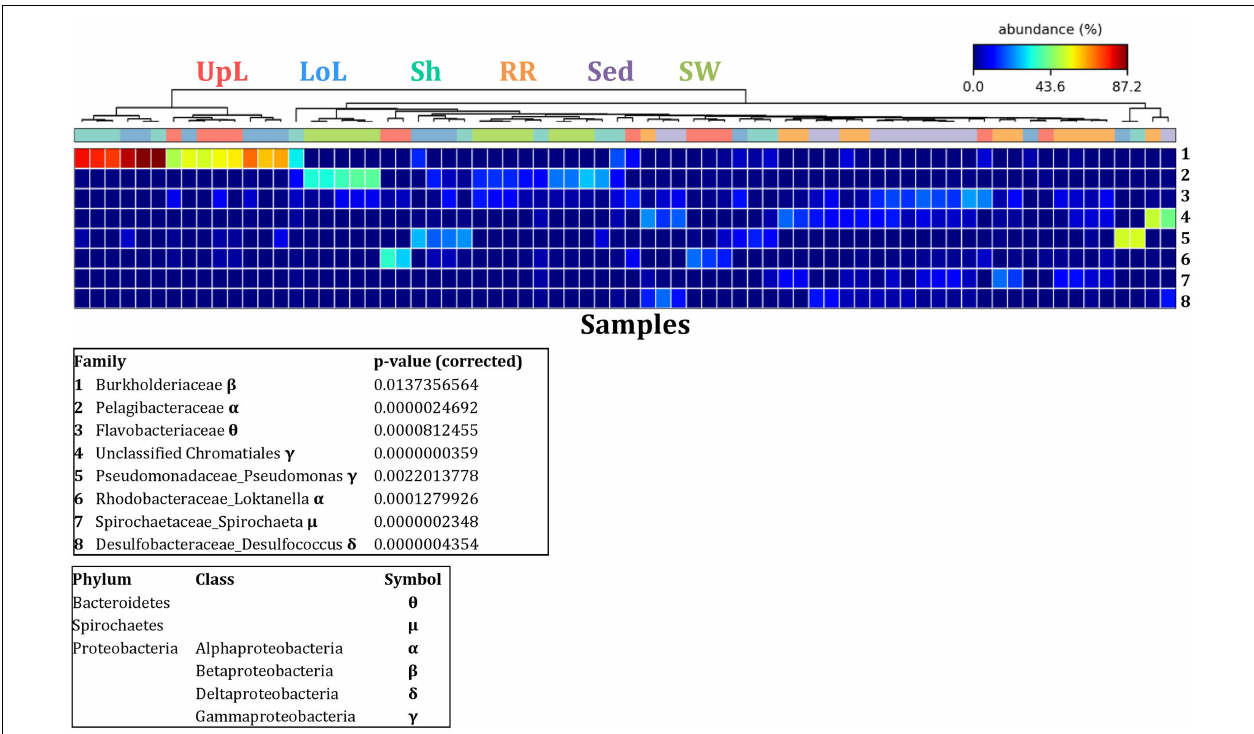
FIGURE 5 | Bacterial discriminatory OTUs at the microenvironmental scale. Extensive hypothesis testing of taxonomic profiles was coupled with similarity percentages analyses (SIMPER) for bacterial microbiomes across the six microenvironments. The proportion of sequences (mean frequency %) of OTUs significantly over-represented (Kruskal–Wallis H -test, α = 0.05, effect sizes: η 2 ) and consistently contributing to the differences between microenvironments is indicated by varying color intensities. Corrected p -values were calculated using the Benjamini–Hochberg’s approach. Two-way crossed SIMPER analyses were performed with site and microenvironment variables as factors (S17 Bray–Curtis similarity matrix). High contributors were selected from the top-5 contributors of each pair-wise comparison between microenvironments, and those OTUs consistently accounting for the dissimilarities between any given microenvironment and at least three other microenvironments were chosen as high contributors to couple with the statistical results. High contributors that were significantly over-represented were classified as discriminatory OTUs (i.e., 1–8). OTUs are sorted by decreasing mean abundance, and samples are clustered by average neighbor distance (UPGMA, distance threshold = 0.75) and colored by microenvironment. Different symbols represent the distribution of enriched phyla. UpL, upper leaf; LoL, lower leaf; Sh, sheath; RR, roots and rhizomes; Sed, sediment; SW,